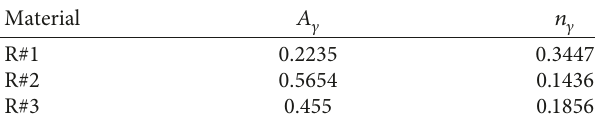
Figure 12: Relationship between shear modulus and damping ratio for 15% rubber content.